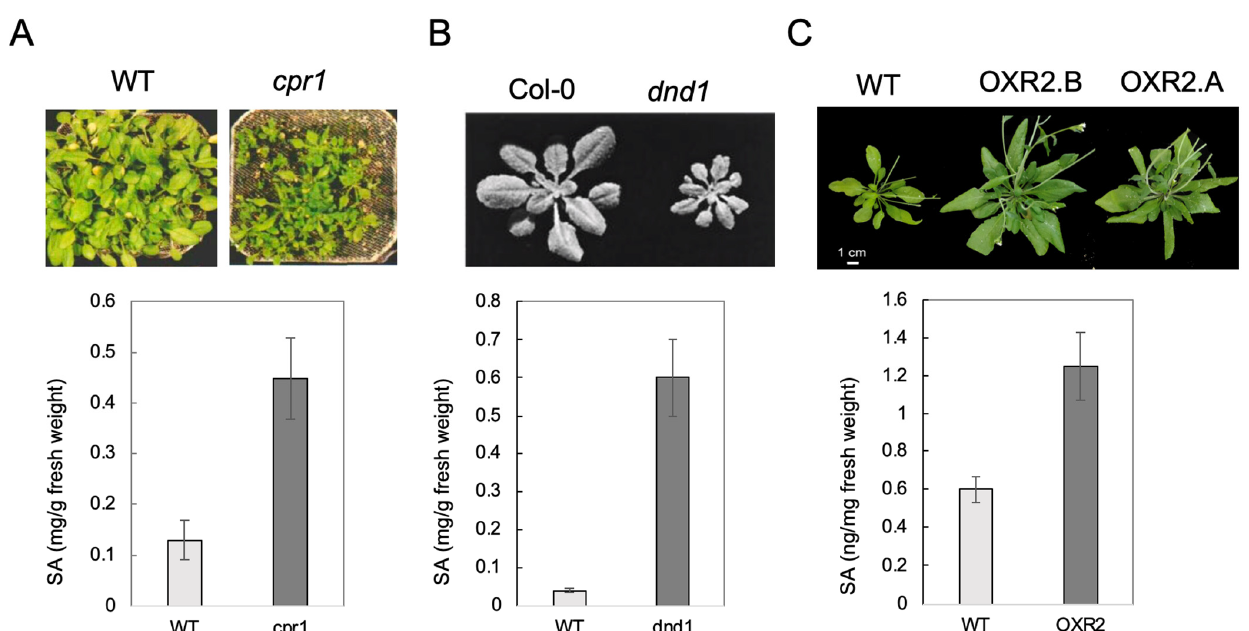
Figure 1. Three different mutants that show constitutively increased SA levels. The comparison with previously published data was made to further illustrate the differences between dwarfed growth phenotypes of plant lines with high SA and the OXR2 overexpressor lines that exhibit an elevated growth from this study. ( A ) Comparison of WT and cpr1 mutant; pictures are with permission from [34] (copyright 1994, Oxford University Press). ( B ) Comparison of WT and dnd1 mutant; pictures are with permission from [36] (copyright 2000, National Academy of Sciences, USA). ( C ) Comparison of WT and constitutive OXR2 overexpressor plants; pictures from R. Mencia, this manuscript. All data panels were redrawn with editorial or author permissions [34,35,40].